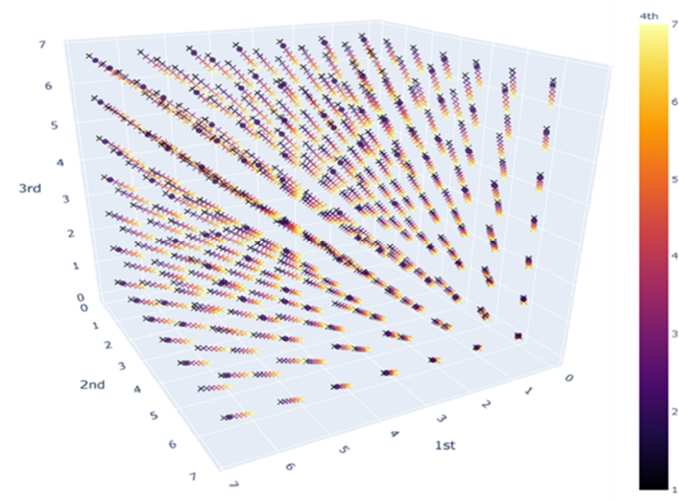
Figure 2. Distribution of input data.